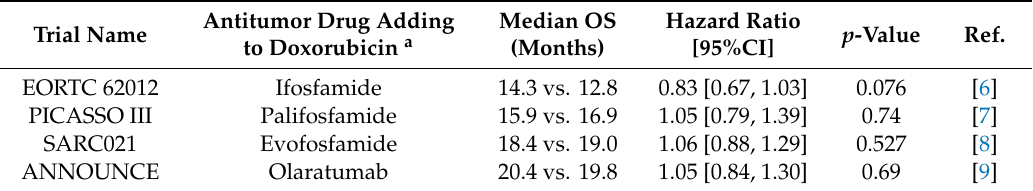
Table 1. Phase 3 clinical trials comparing doxorubicin combination with another antitumor drug to doxorubicin monotherapy in STS